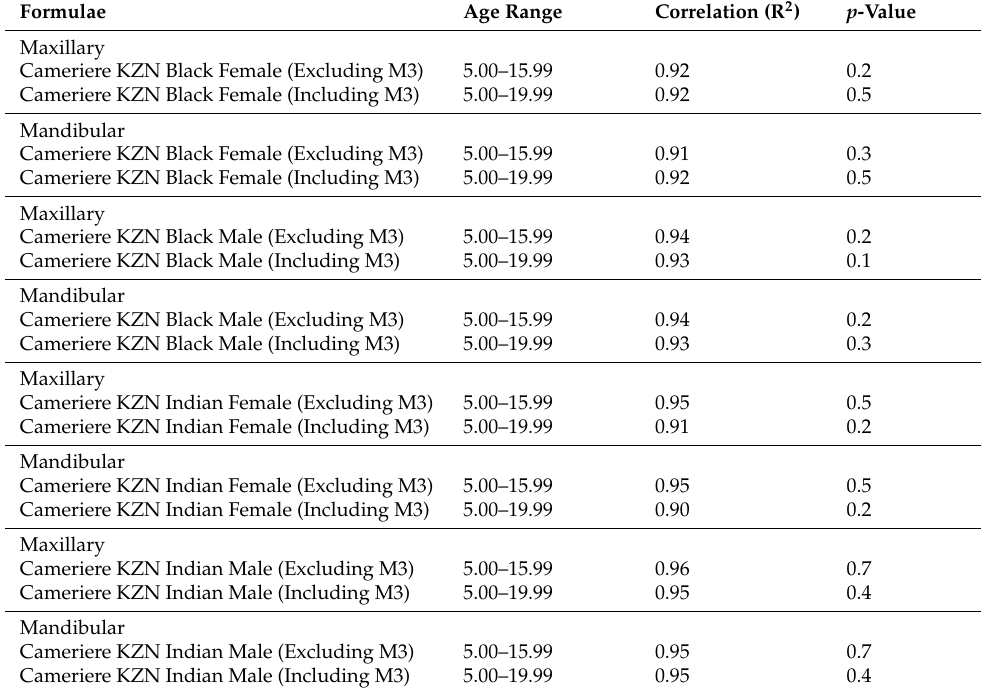
Table 6. Efficiency of the KZN Formulae of the Cameriere method. Formulae Age Range Correlation (R 2 ) p